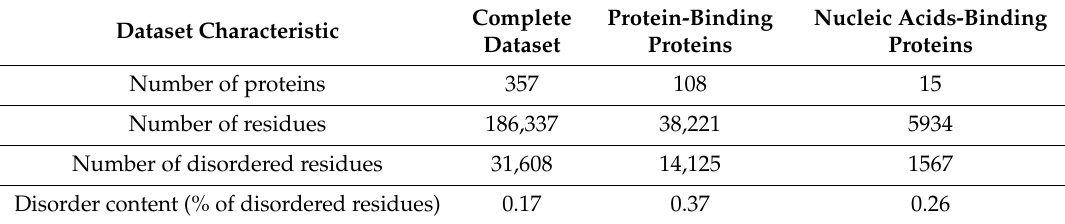
Table 2. Summary of the Benchmark